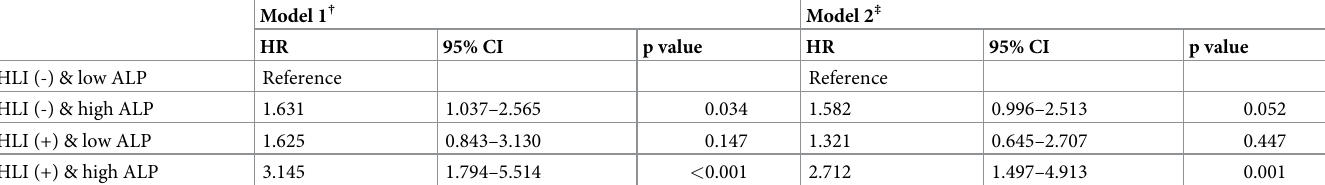
Table 5. Combined predictive value of hypoxic liver injury (HLI) and alkaline phosphatase (ALP) level for major adverse cardiac and cerebrovascular events